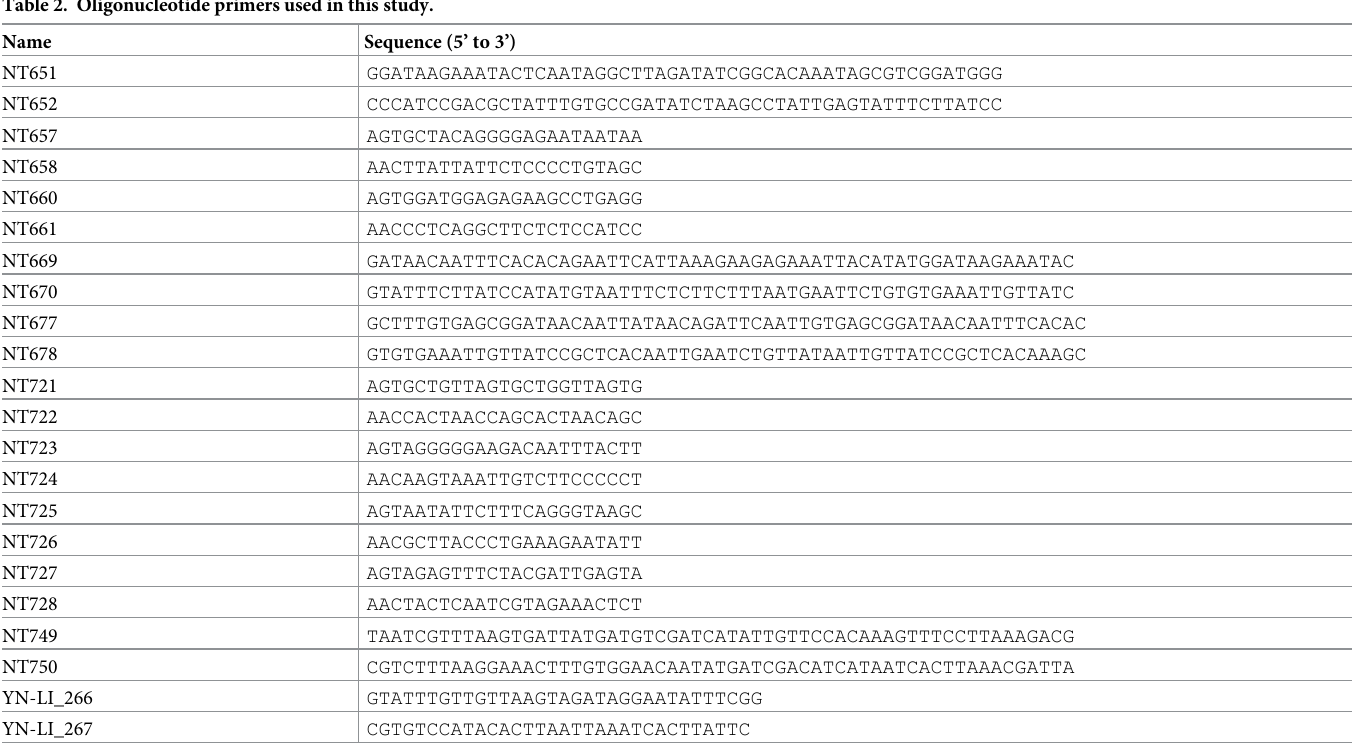
Table 2. Oligonucleotide primers used in this study.